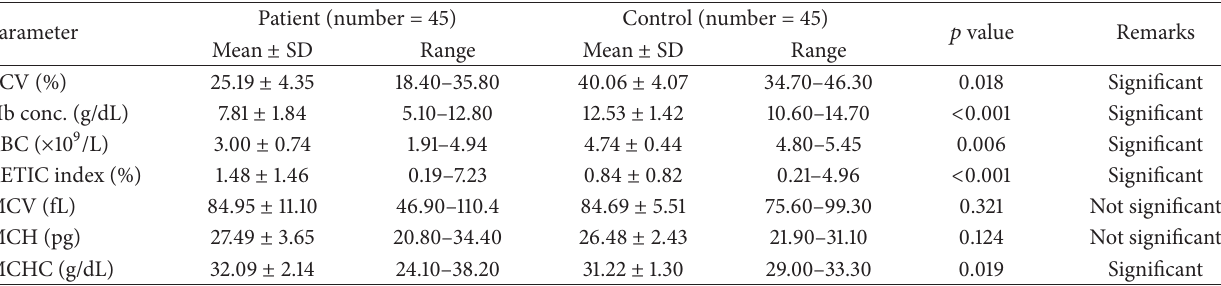
Table 1: Red blood cell indices in patients and controls.